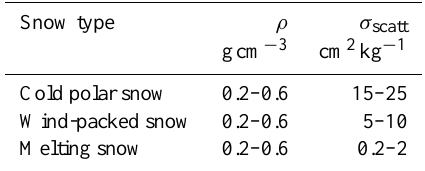
Table 2. Properties of snow type studied. Optical and physical prop- erties are based on work by Marks and King (2014) and references